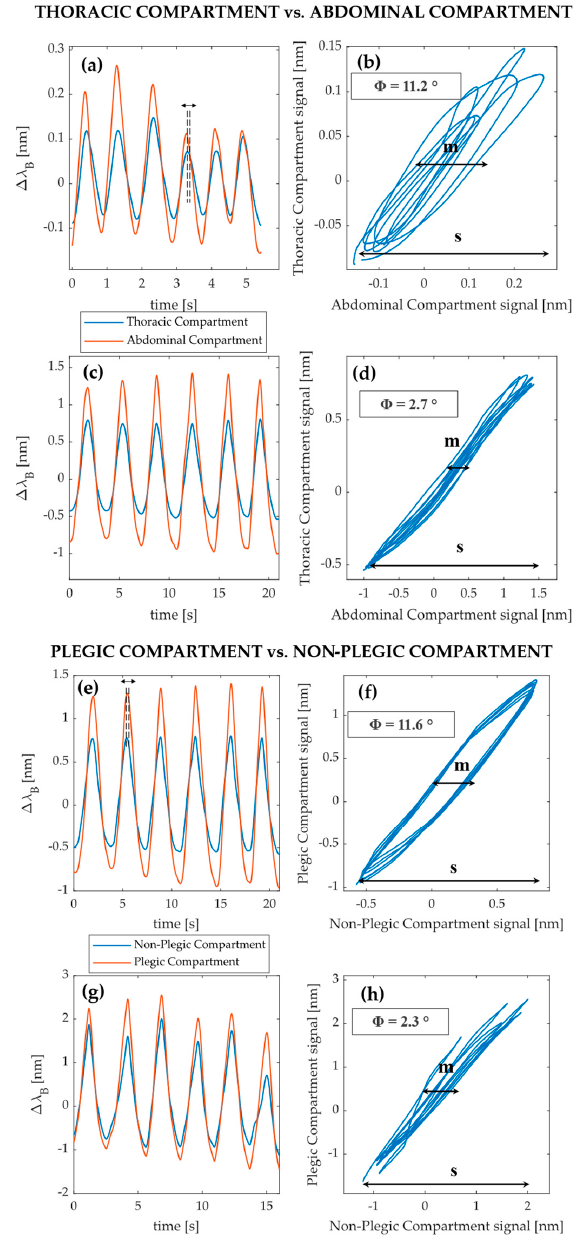
Figure 5. Phase shift analysis between thoracic and abdominal compartments and plegic and non- plegic compartments. Plots of thoracic and abdominal compartments’ signals in time for two different subjects are shown in ( a , c ). In ( a ), a phase shift is shown, while in ( c ), no significant shifts are visible. Lissajous figures of the out-of-phase ( b ) and in-phase ( d ) signals are reported, together with the related phase angle value. Plots of plegic and non-plegic compartments’ signals in time for two different subjects are reported in ( e , g ). In ( e ) and in ( g ), out-of-phase and in-phase signals are shown, respectively. Lissajous figures of the out-of-phase ( f ) and in-phase ( h ) signals are reported, together with the related phase angle